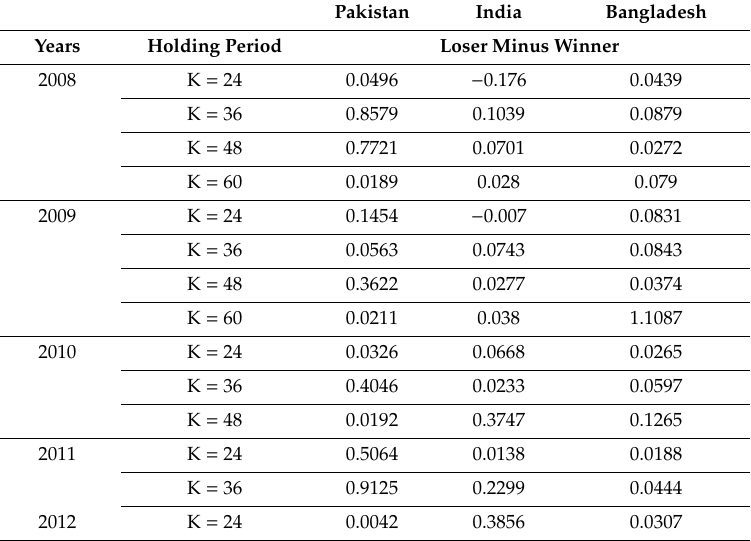
Table 2. Returns from contrarian strategy for di ff erent holding